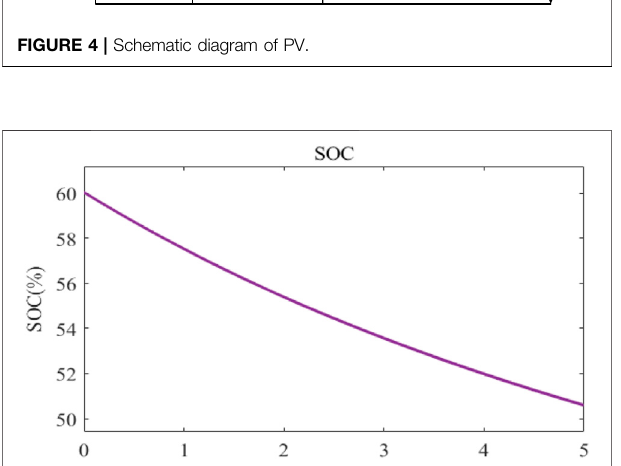
FIGURE 5 | Performance of the battery under the